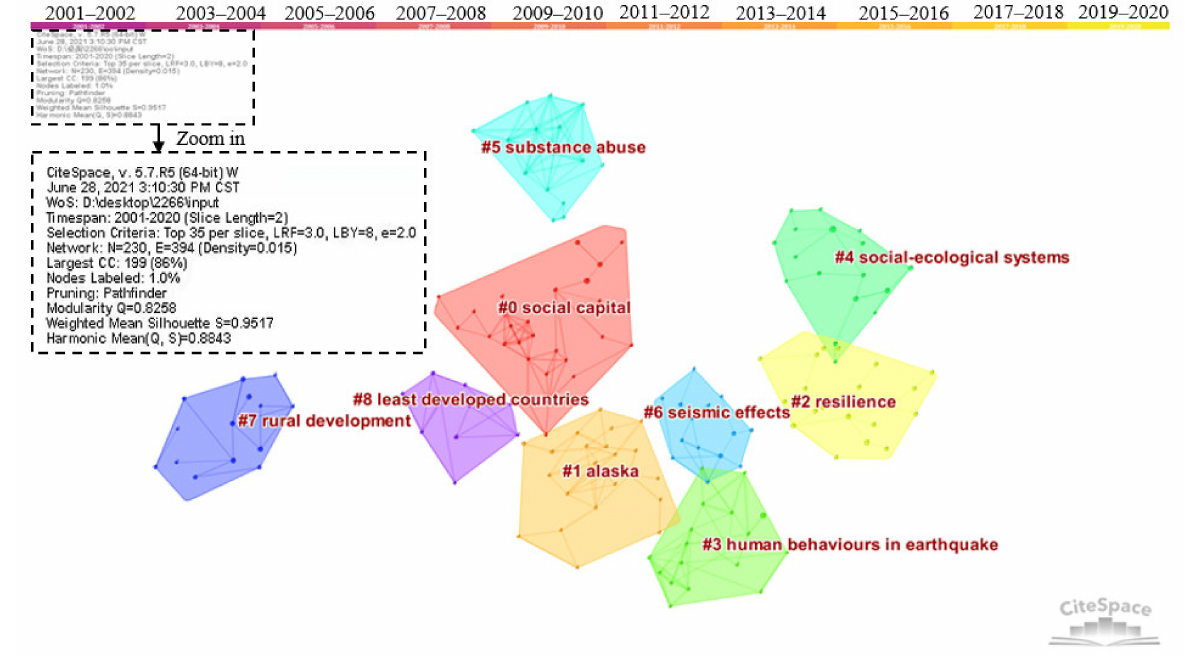
Figure 11. Cluster of co-citation document